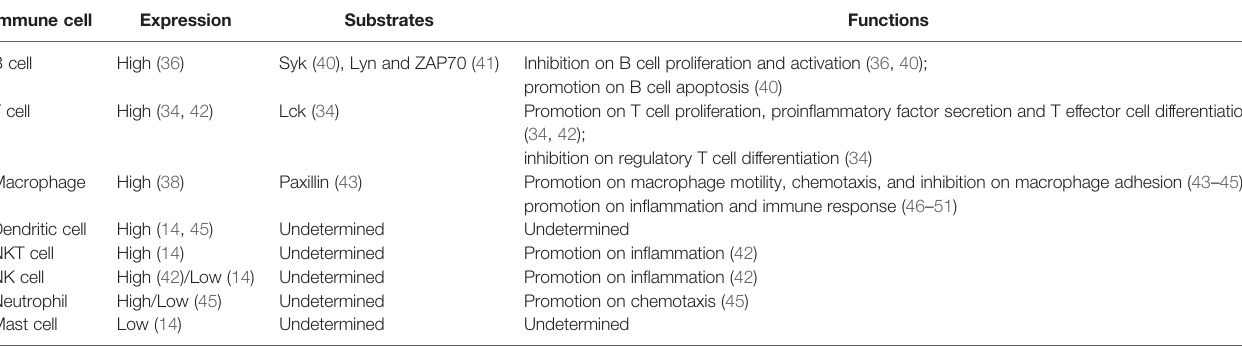
TABLE 1 | PTPRO/PTPROt expression, substrates and functions in immune cells. Immune cell Expression Substrates